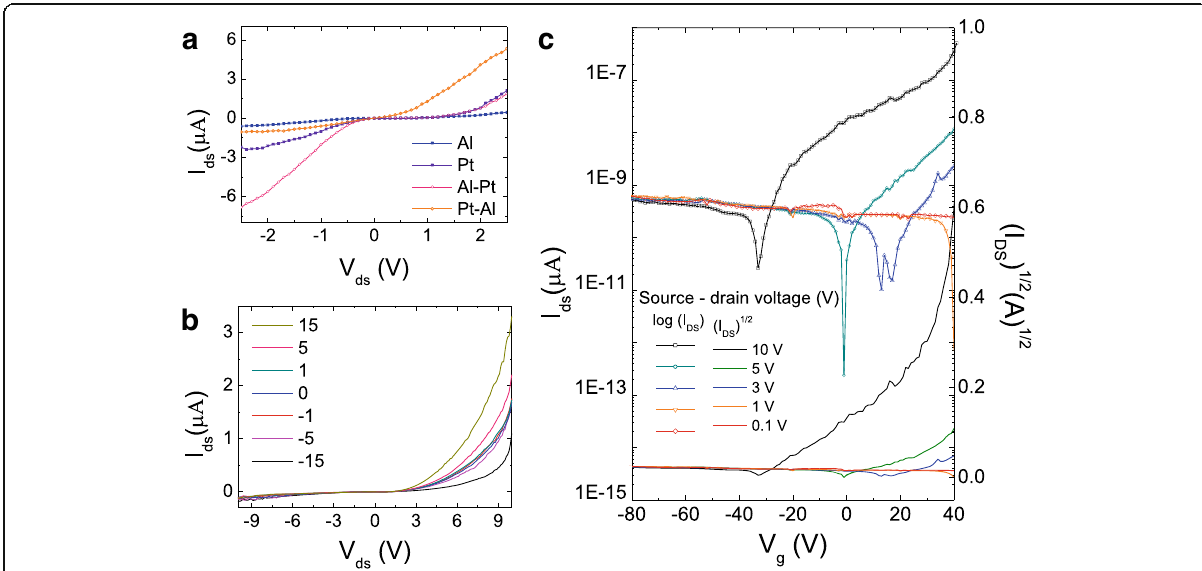
Fig. 4 a I-V DS curve of the MoS 2 device with symmetric electrodes (Al-Al, Pt-Pt) and asymmetric electrodes (Al-Pt). b Transfer curve and c output curve of the asymmetric devices